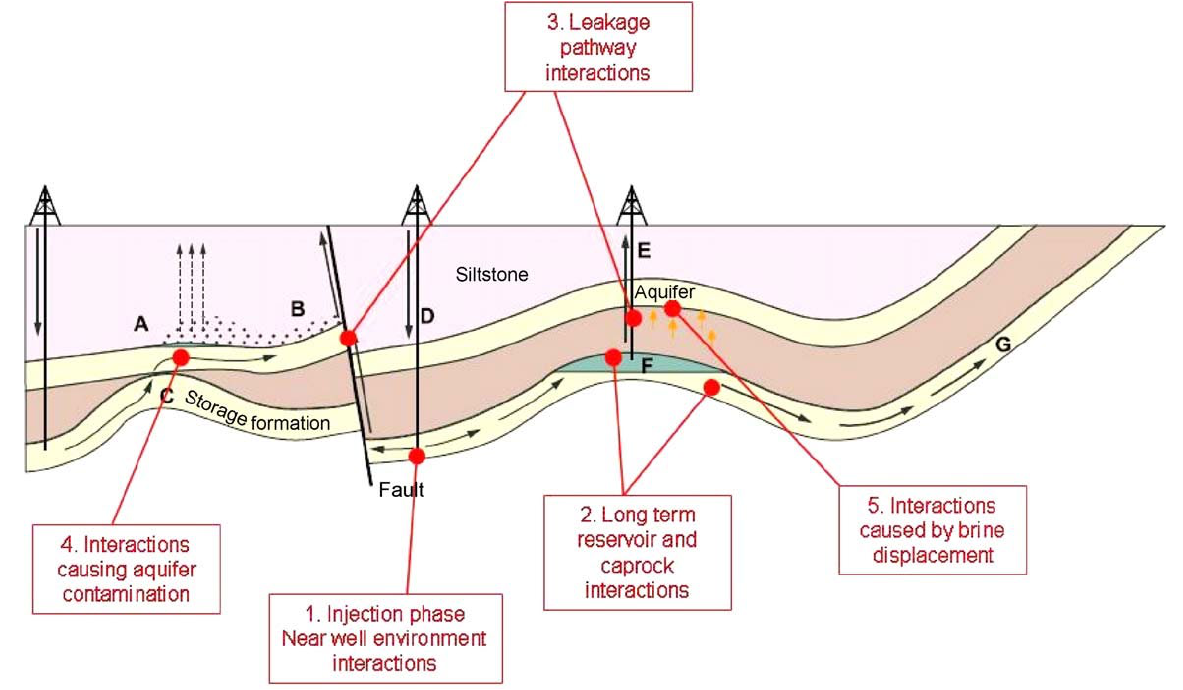
Figure 4. Schematic diagram of a CO 2 injection scheme and identified clusters of CO 2 –rock interac- tion [34]. (Noted: The letters A to G represent CO 2 potential escape mechanisms. A: CO 2 gas pressure exceeds capillary pressure and passes through siltstone; B: Free CO 2 leaks from A into upper aquifer up fault; C: CO 2 escapes through ‘gap’ in cap rock into higher aquifer; D: Injected CO 2 migrates up dip, increases reservoir pressure and permeability of fault; E: CO 2 escapes via poorly plugged old abandoned well; F:Natural flow dissolves CO 2 at CO 2 /water interface and transports it out of clo- sure; G:Dissolved CO 2 escapes to atmosphere or ocean.) 3.2. Risks of CO 2 Storage Leakage.